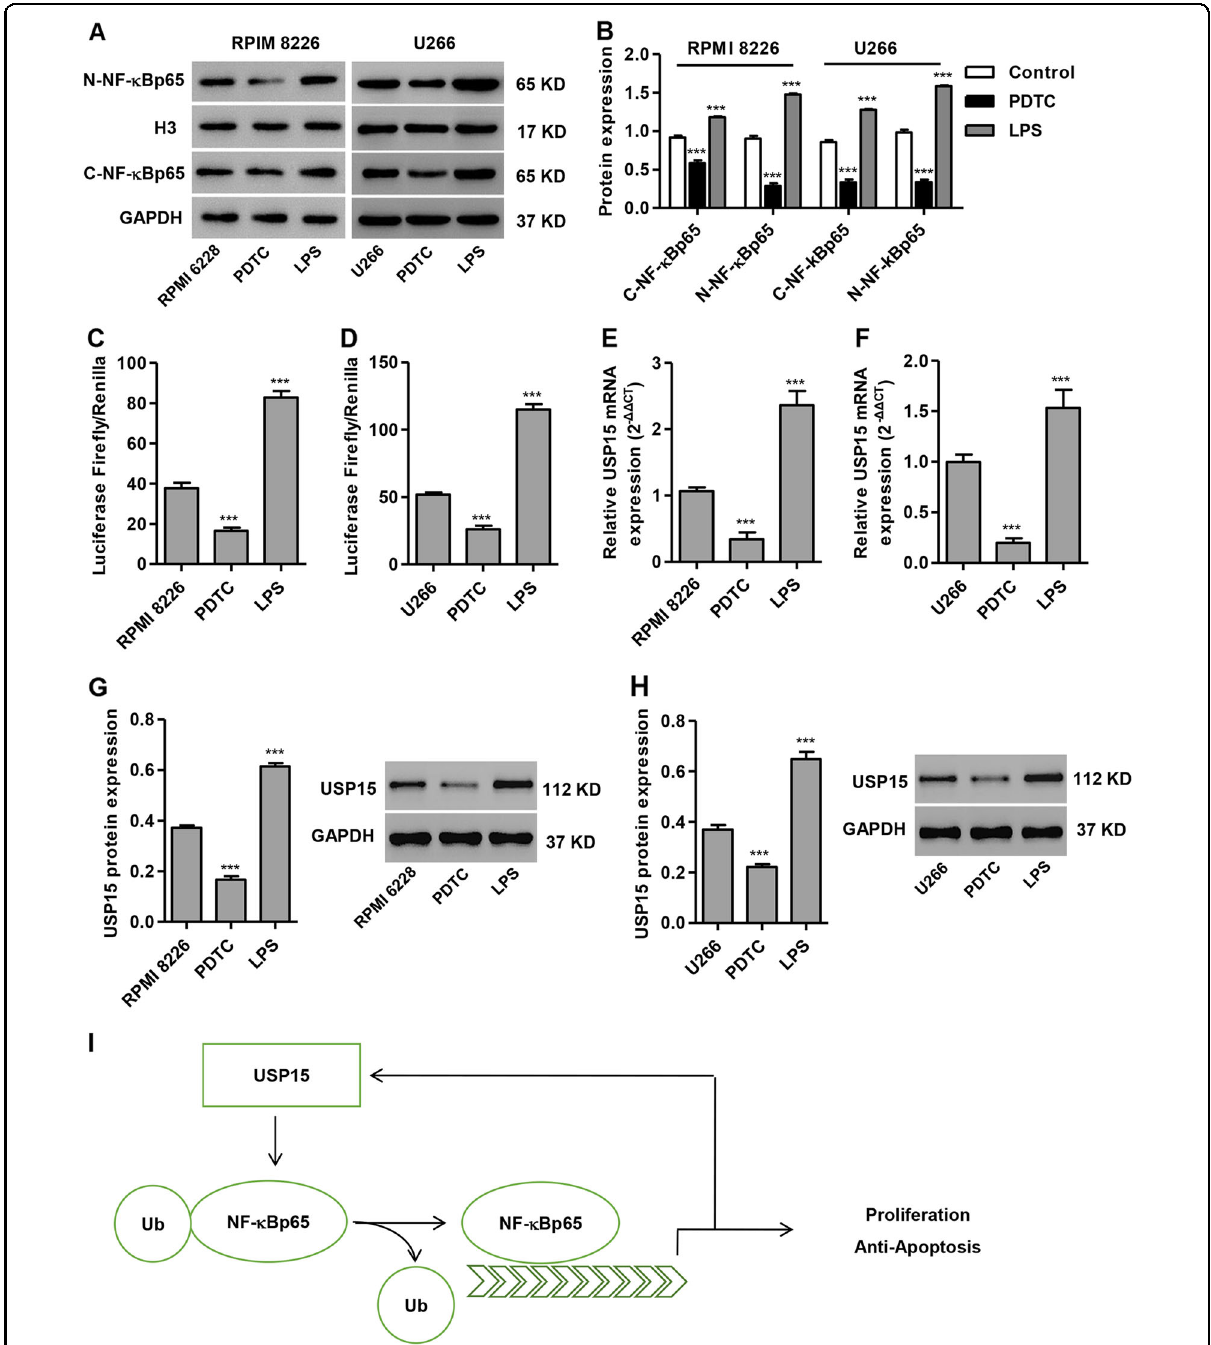
Fig. 8 Regulatory feedback between USP15 and NF- κ Bp65. a , b After RPMI 8226 and U266 cells were treated with PDTC (50 μ M) or LPS (1 μ g/ml), the expression of nuclear NF- κ Bp65 and cytoplasmic NF- κ Bp65 was measured by western blot. c , d Dual-luciferase assays in RPMI 8226 and U266 cells transfected with fi re fl y luciferase constructs containing the 3 ′ UTR of USP15 with or without PDTC (50 μ M) and LPS (1 μ g/ml) treatment. After RPMI 8226 and U266 cells were treated with PDTC (50 μ M) or LPS (1 μ g/ml), the expression of USP15 was measured by Real-time PCR ( e , f ) and western blot ( g , h ). i Schematic representation USP15-NF- κ Bp65 regulation of cell proliferation and apoptosis. *** P < 0.001 compared with untreated